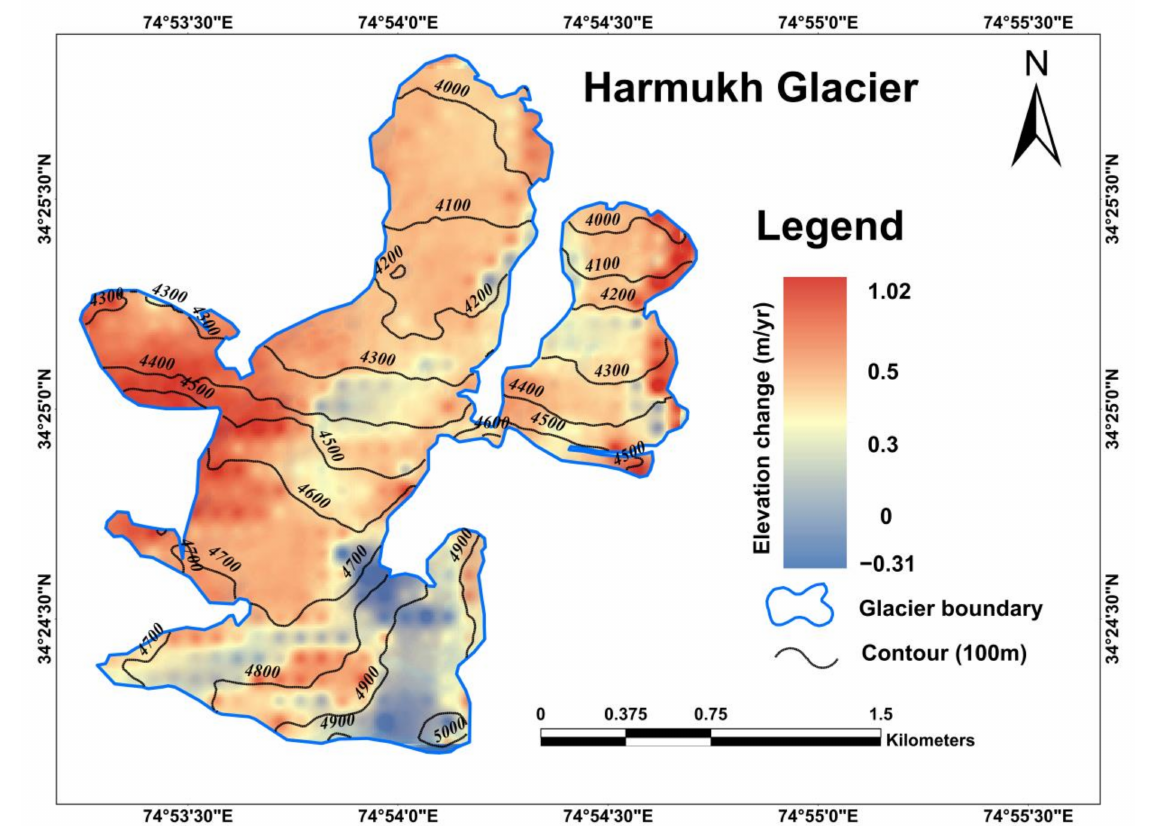
Figure 9. Spatial distribution of elevation changes over Harmukh glacier from 2000 to